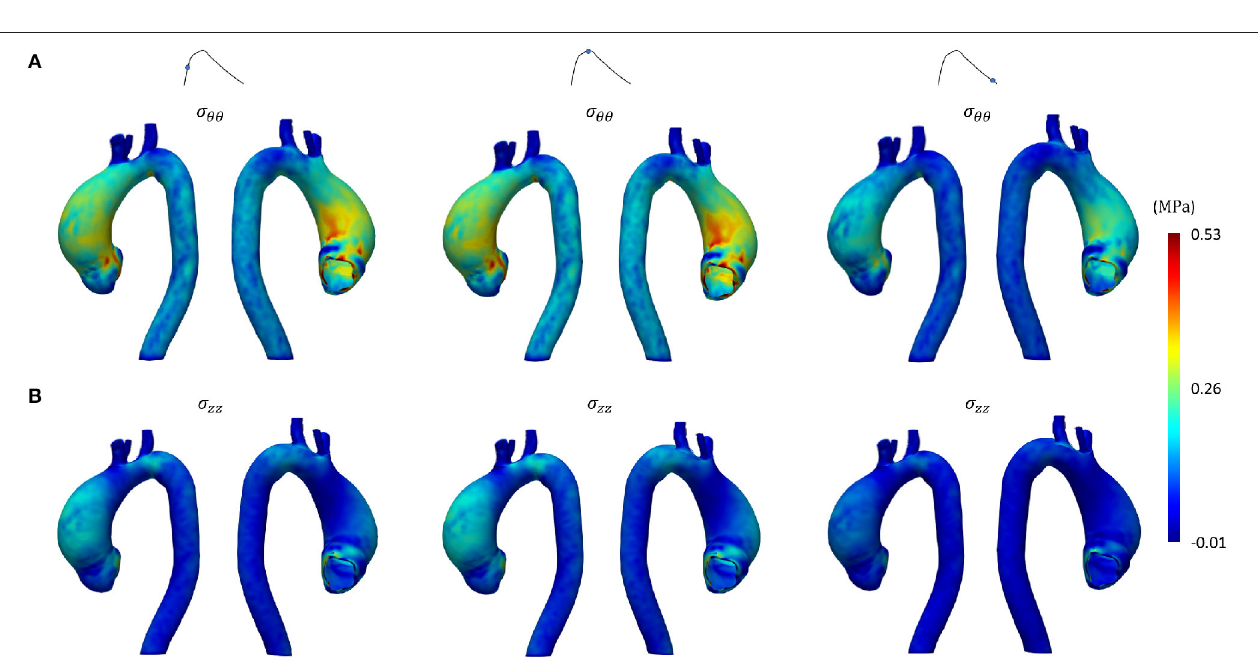
FIGURE 9 | Structural results from non-linear FSI at early systole, peak systole and late diastole in terms of (A) circumferential and (B) longitudinal stress.